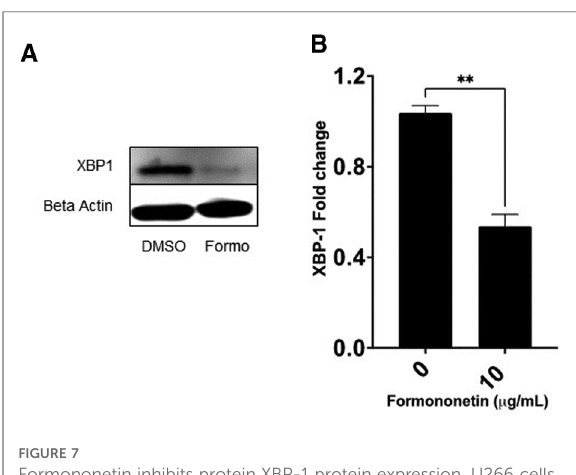
FIGURE 7 Formononetin inhibits protein XBP-1 protein expression. U266 cells were cultured with formononetin for 72 h and protein expression was determined using western blotting. ( A ) Western Bands ( B ) XBP-1 protein expression. Data represents triplicate experiments and expressed as mean±SD. ** p <0.01 vs. control (0.1%